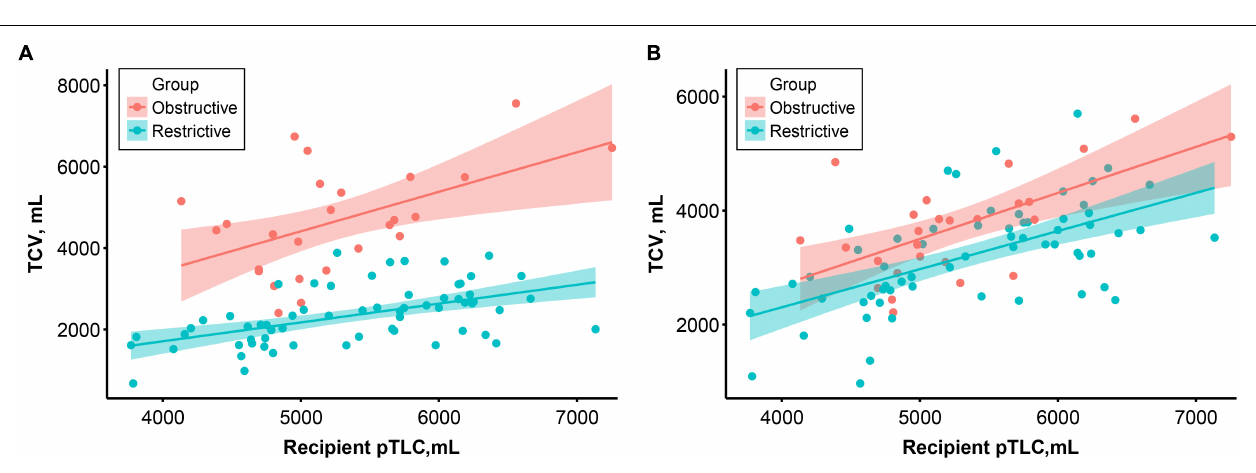
FIGURE 3 | Correlation between recipient predictive total lung capacity (pTLC) and preoperative (A) and 1-year postoperative (B) thoracic cavity volume according to the study groups. Colored lines and areas indicate the regression lines and 95% confidence intervals,